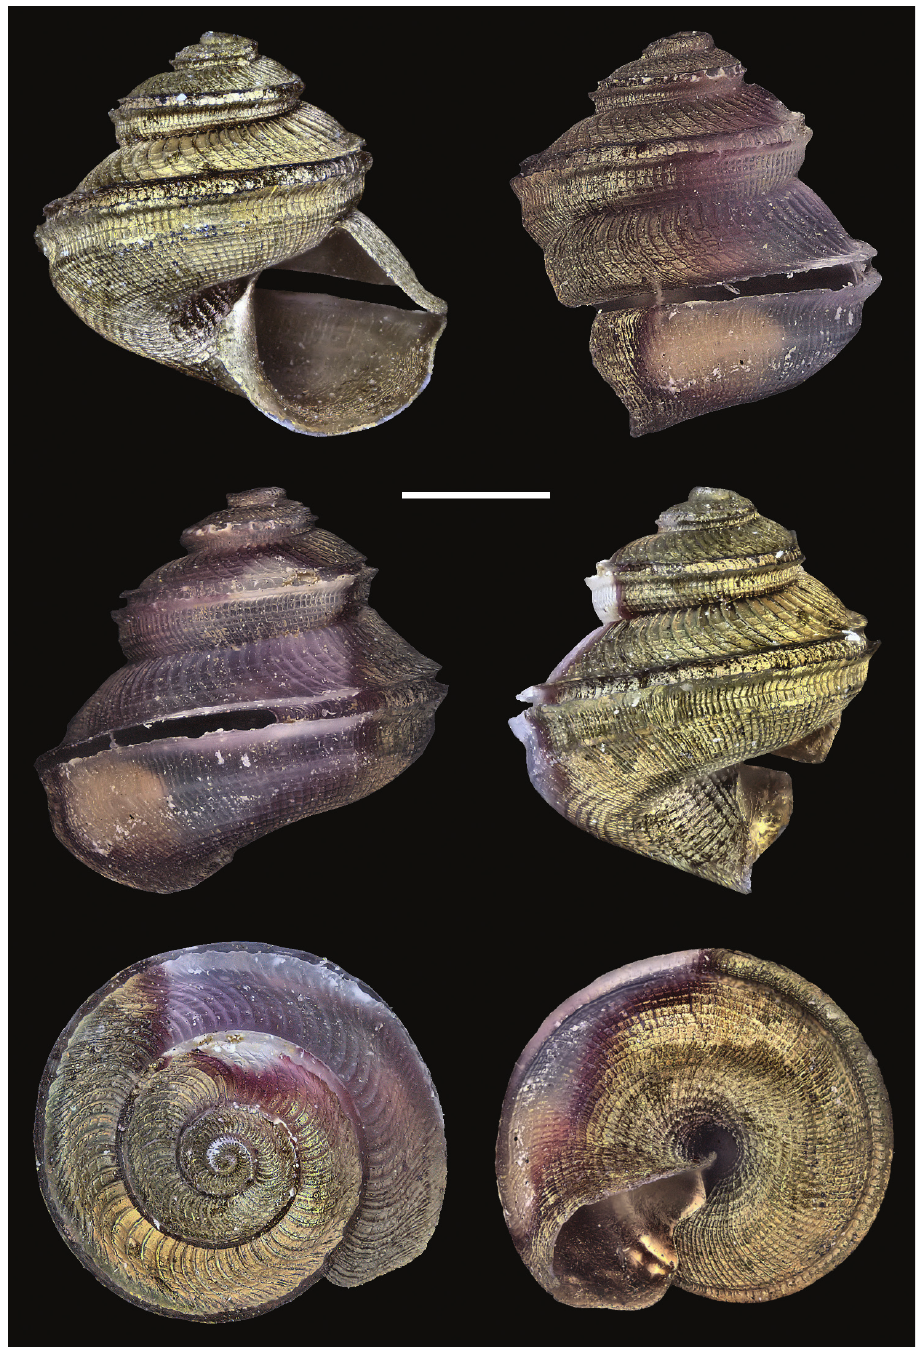
Figure 17. Scissurella agulhasensis Thiele, 1925. Neotype T1916/NMSA-MOL 0W181. Scale bar: 1